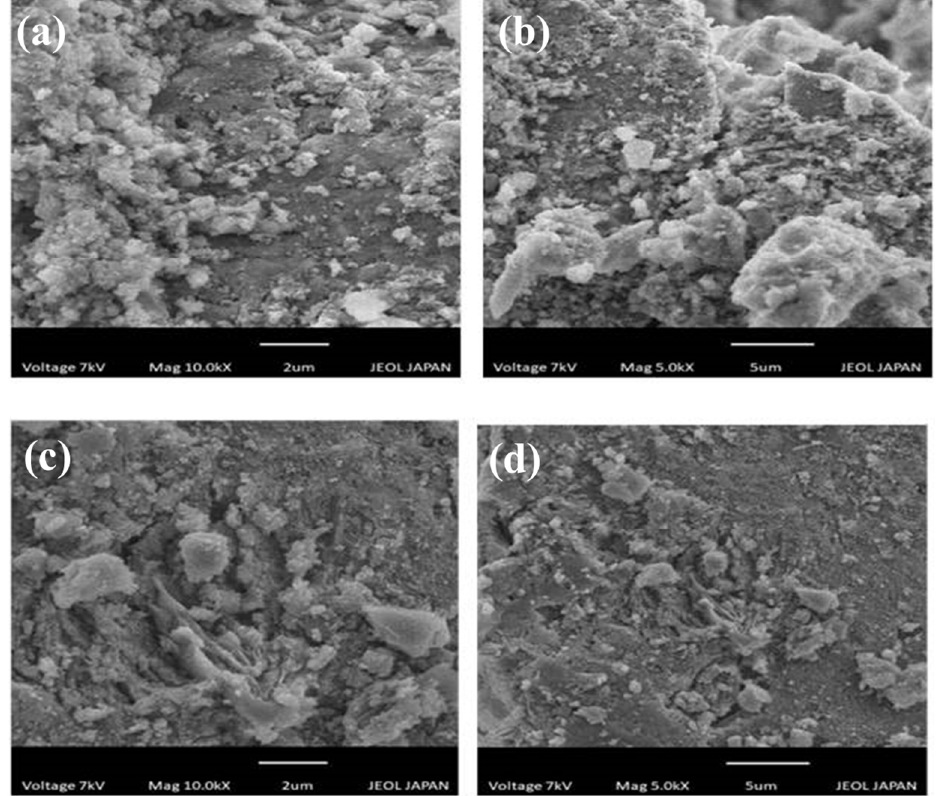
Figure 2. SEM images of ( a , b ) raw bentonite and ( c , d ) cinnamic acid modified